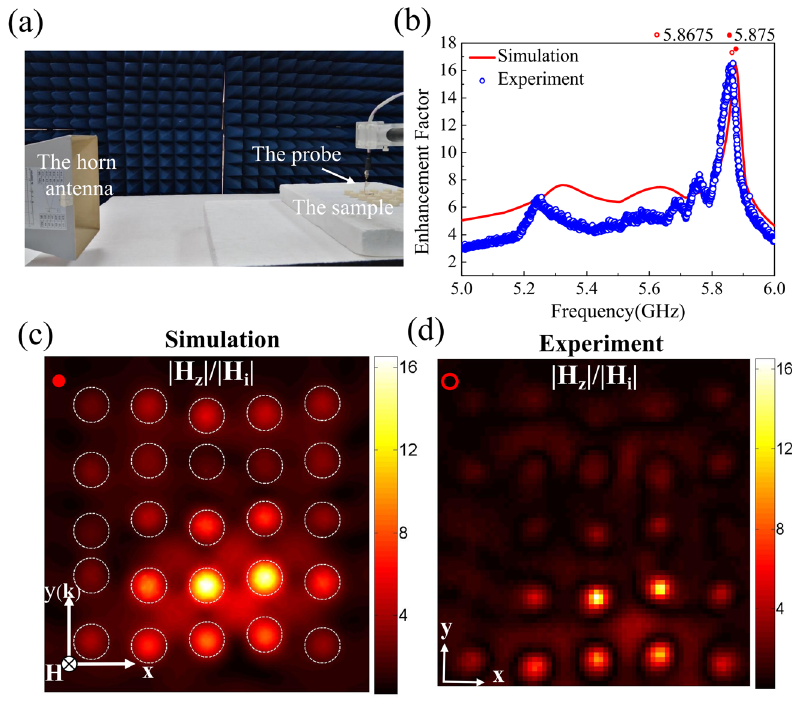
Figure 4: (a) The experimental setup for measuring the near-field enhancement of magnetic field. (b) The measured frequency dependence of enhancement factors of | S 21 | that is proportional to the magnetic fi eld | H z | and the corresponding calculated maximum of magnetic fi eld enhancement factor on a plane 3 mm away from the surface of the structure. (c) and (d) The corresponding calculated normalized magnetic fi eld | H z | and measured | S 21 | distributions at the maximum of magnetic fi eld enhancement, whichareachievedat5.875and5.8675GHz, respectively. The resolutions of Figure 4(c) and (d) are 0.8 and 2 mm,